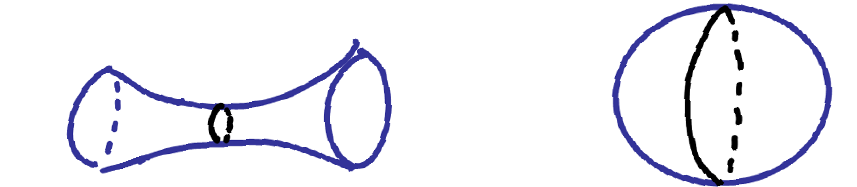
Figure 1 . On the left, we show an extremal surface (in black) bisecting a spatial slice (blue) of the eternal AdS black hole in d = 2. It corresponds to the entanglement entropy obtained by tracing over one of the CFTs in the thermo(cid:12)eld double state (1.1). On the right, we depict a spatial slice of dS 3 (2.1) at the moment of time symmetry (cid:28) = 0, bisected by the extremal surface (in black) at the ultraviolet slice w = (cid:25)‘ dS = 2. Its area corresponds to the entanglement entropy obtained by tracing over one of the two coupled CFTs in the dual of de Sitter. Given the maximally mixed density matrix derived from the Renyi entropies, we match the entanglement entropy, including its numerical coe(cid:14)cient. The entropy of the full circle is also the Gibbons-Hawking horizon entropy for an observer O momentarily at the deep IR end of one or the other warped throat, at w = 0 or (cid:25)‘ dS and (cid:28) = 0. That observer has no interaction with the second CFT, and must trace over it. See (cid:12)gure 2 below for the corresponding space-time